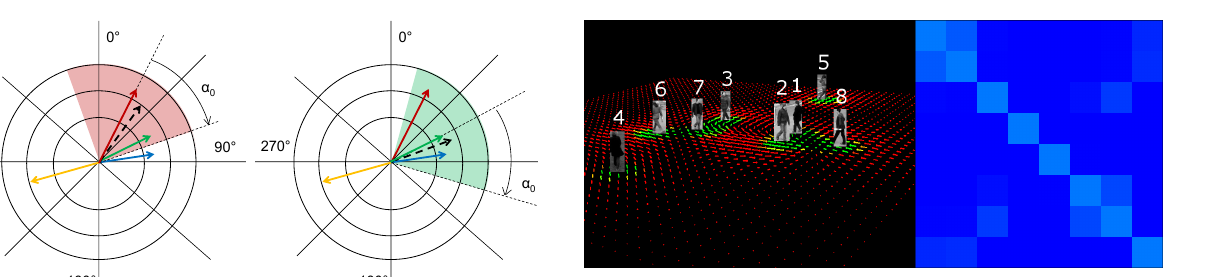
Figure 3. Motion vector field with covariances as a function of the distance only. The magnitudes of the velocities are exaggerated by a factor of two for